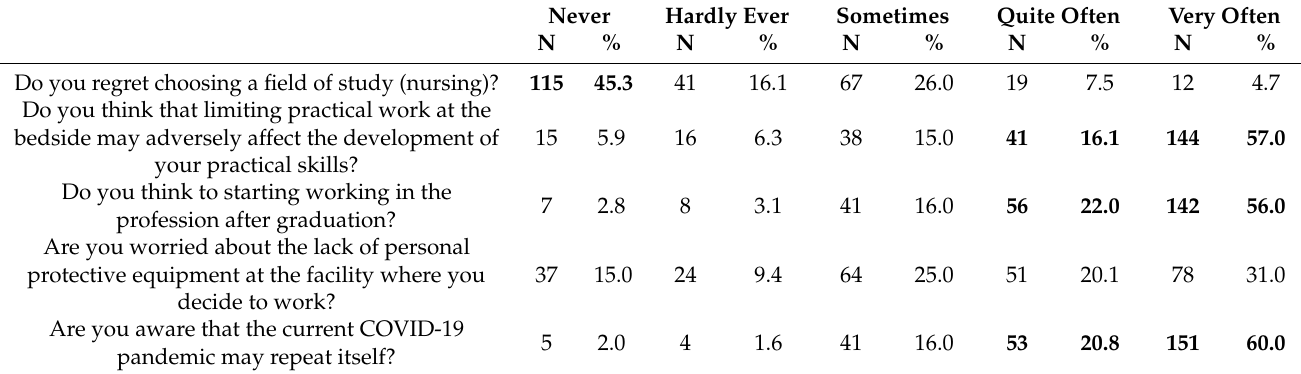
Table 2. Students’ perception of their study and intention to professional practice (N =